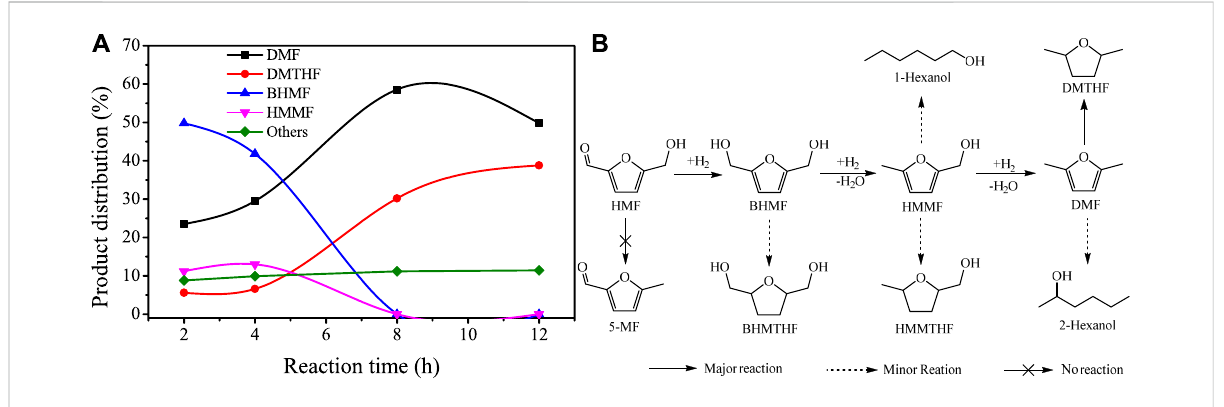
FIGURE 4 Reaction pathway study of HMF hydrogenolysis over Cu/SiO 2 -HT-8.5 catalyst. (A) Product distribution of HMF hydrogenolysis at different reaction time; (B) Proposed reaction pathways for HMF hydrogenolysis over Cu/SiO 2 -HT-8.5 catalyst. Reaction conditions: 0.05 g HMF, 0.05